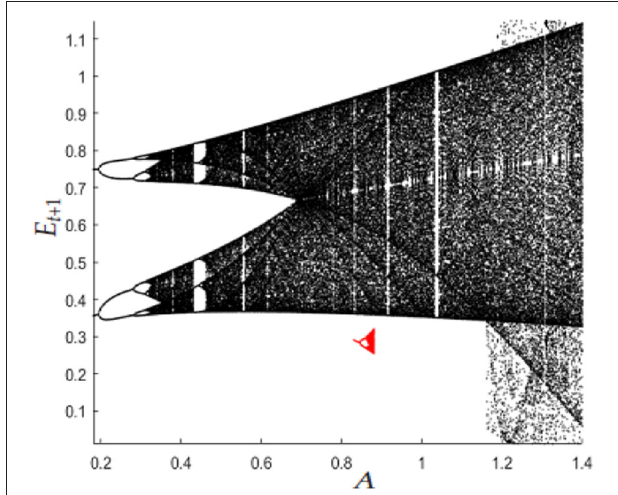
FIGURE 3 | Parameter set: α = 0.07, β = 0.1, η E = 11, ρ = 12, N = 100, δ = 0.4, γ = 0.04, b = 0.58, E = 22. The part of the bifurcation diagram depicted in black is generated starting from E 0 = 0.6. The part depicted in red shows the existence of a second attractor for A ∈ [0.83,0.88] (the initial condition is E 0 = 0.29).